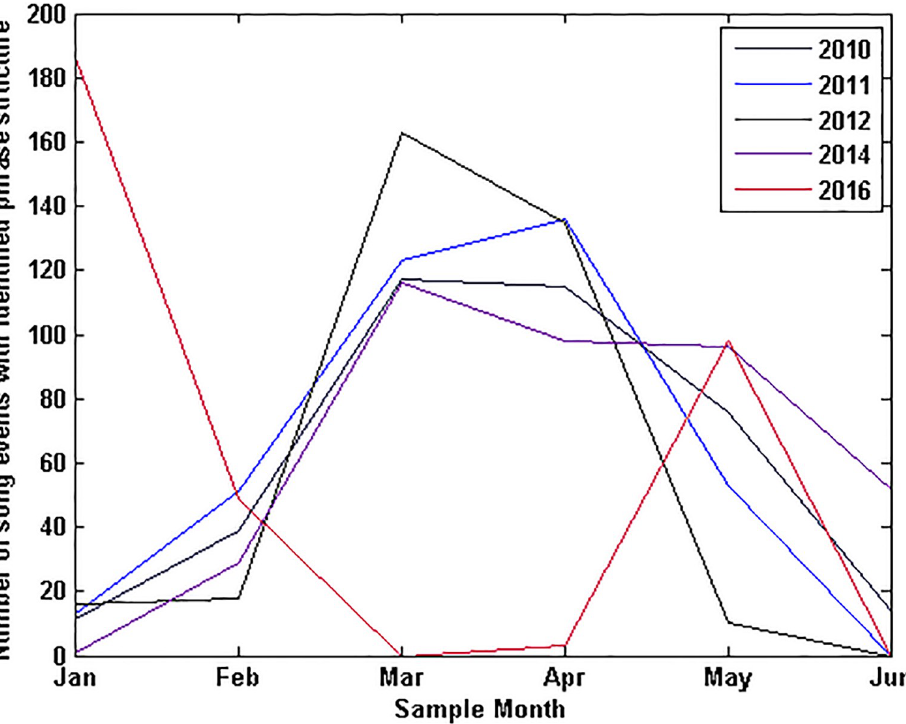
Fig 5. Identified singers per year. Distribution events where song structure was identified throughout the calendar